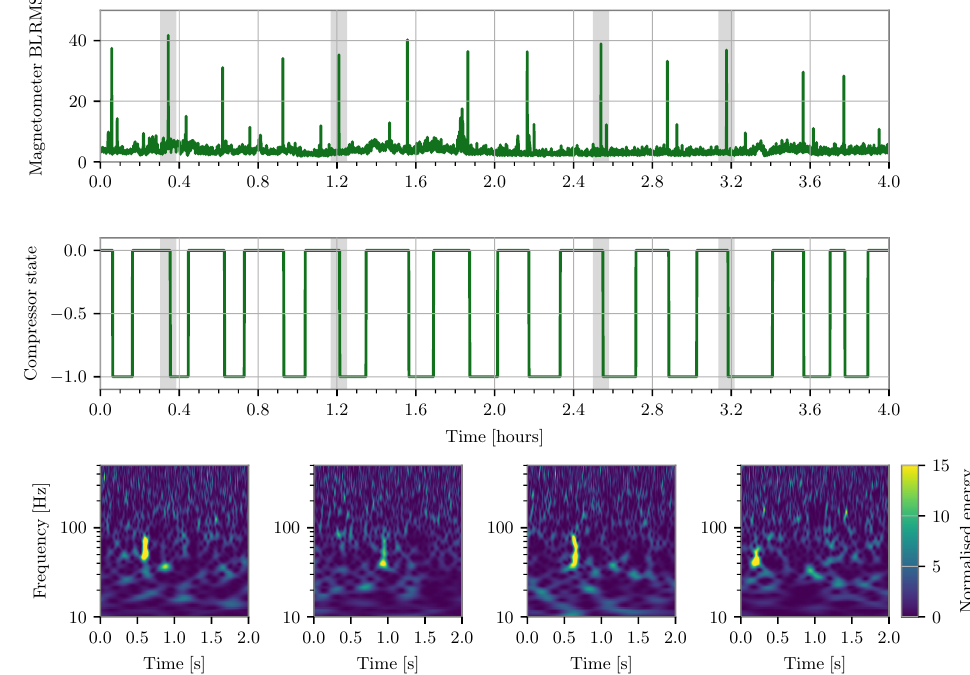
Figure 4. A comparison of time series of a channel showing the band-limited RMS of a magnetometer signal ( top ) and a signal from a compressor ( middle ) over the course of several hours. These channels were found to be significantly correlated with glitches in the strain channel from the HVeto algorithm. For the four peaks in the band-limited RMS time series marked by gray shading, the gravitational-wave strain data are also shown ( bottom ). This analysis provided further evidence that the compressor switching on and off was causing magnetic glitches present in the gravitational-wave strain data. Plotted compressor and magnetometer data are from [30] and strain data are accessed from GWOSC